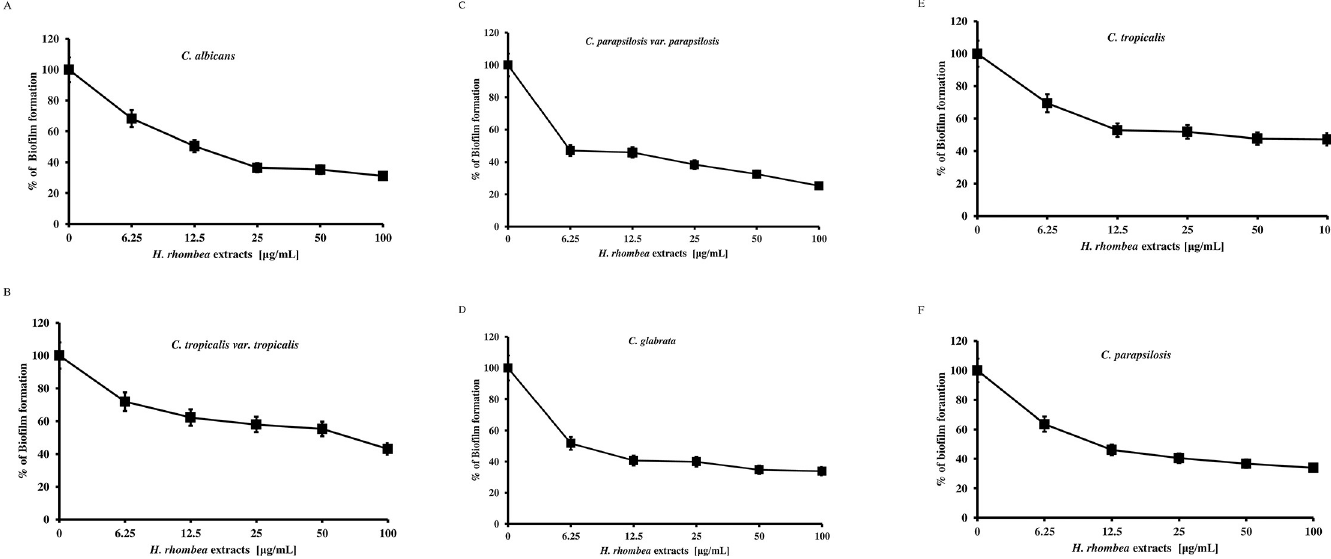
Fig 1. Inhibition of Canddia spp. biofilm formation by H . rhombea extract. T he biofilm formation of (A) C . albicans , (B) C . tropicalis var . tropicalis , (C) C . parapsilosis var . parapsilosis , (D) C . glabrata , (E) C . tropicalis , and (F) C . parapsilosis was induced in YPD media supplemented with 10% fetal bovine serum with the indicated concentrations of H . rhombea extract at 37˚C for